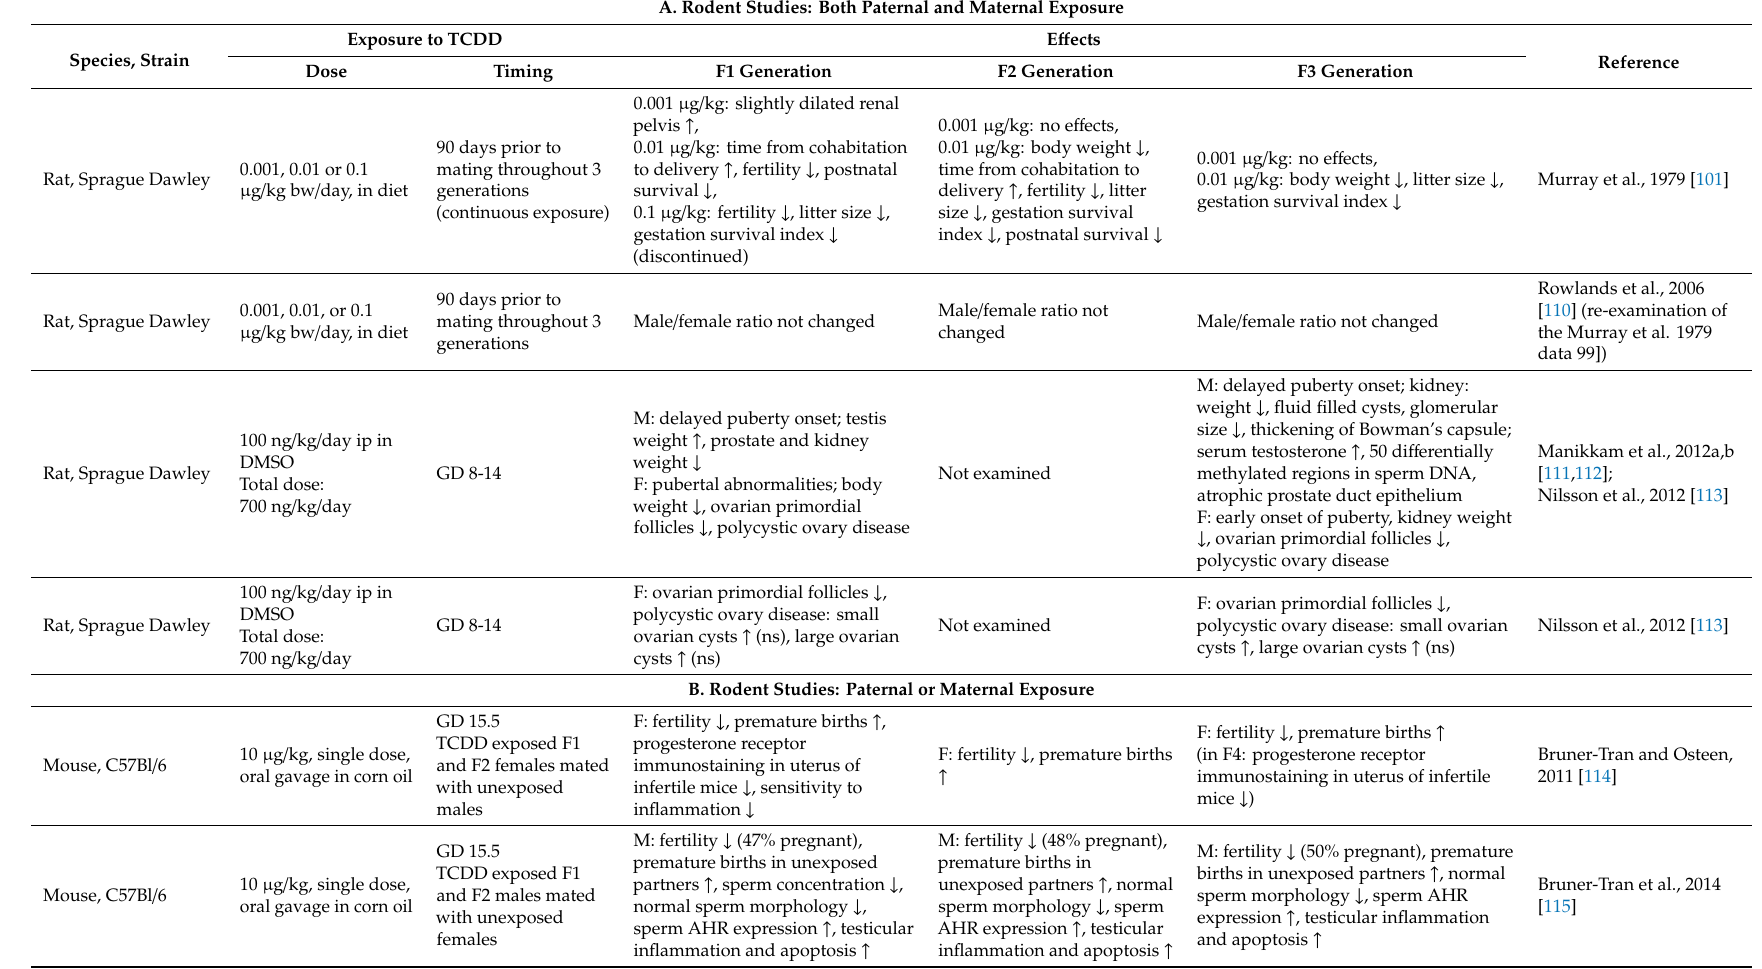
Table 2. Summary of experimental studies on multigenerational and transgenerational (F1–F3) e ff ects of 2,3,7,8-tetrachlorodibenzo-p-dioxin (TCDD) on male (M)